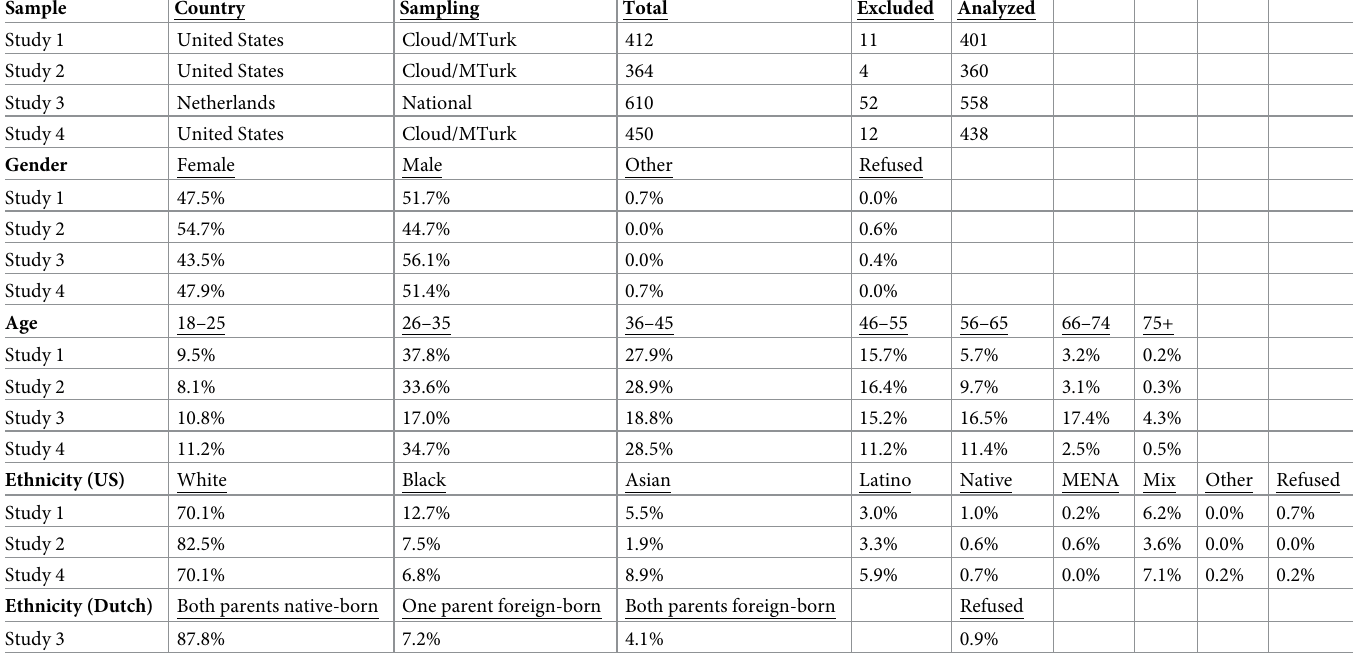
Table 1. Sample and demographic information for studies